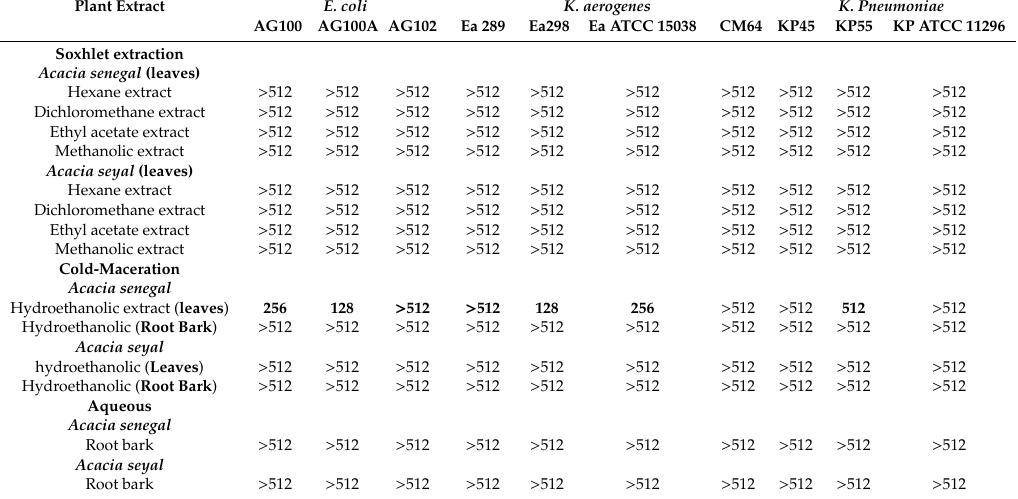
Table 3. Minimal inhibitory concentrations (MICs, mg / L) of the di ff erent extracts against the tested bacterial species. Plant